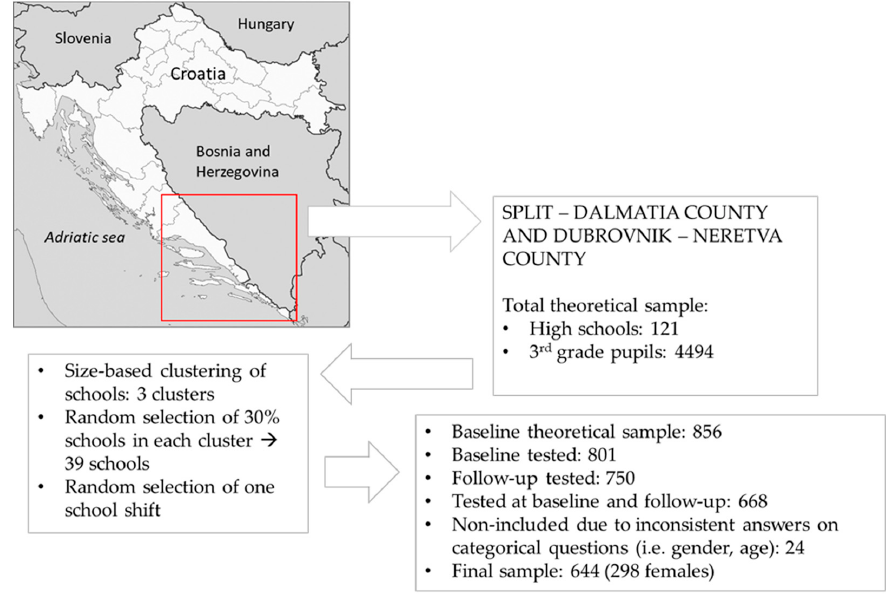
Figure 1. Location of the study, testing sequences, and drop-out rates of the study sample.